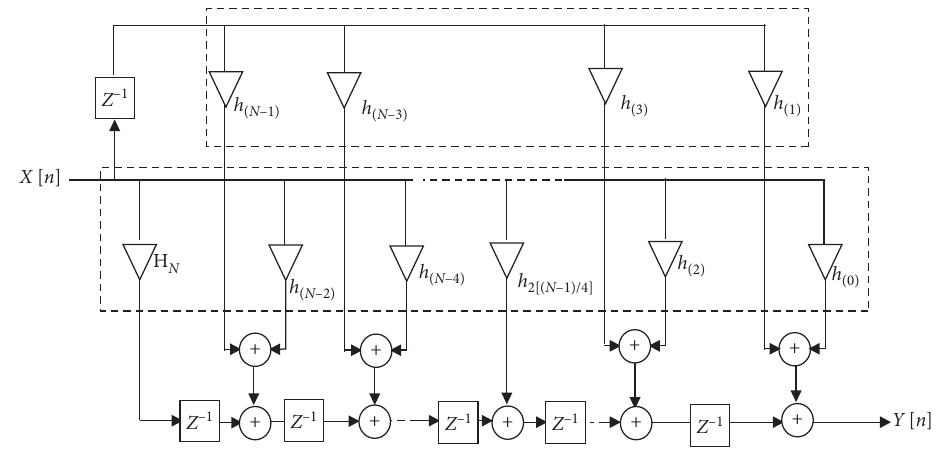
Figure 5: Structure of the FIR filter with an odd order N